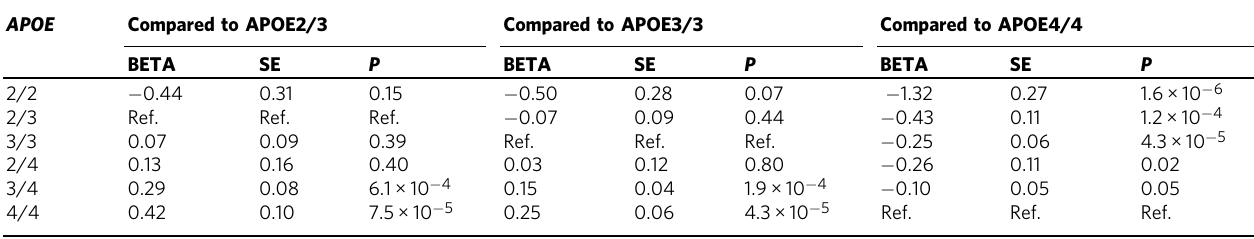
Table 3 Residual effects of Braak stage after adjustment for plaque